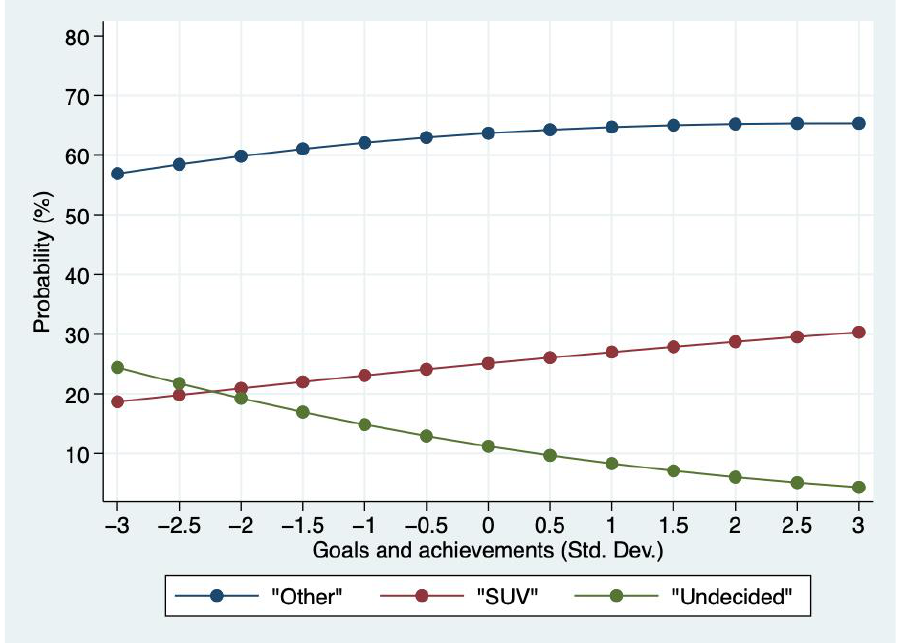
Figure 4. Predictive margins. Goals and achievements.